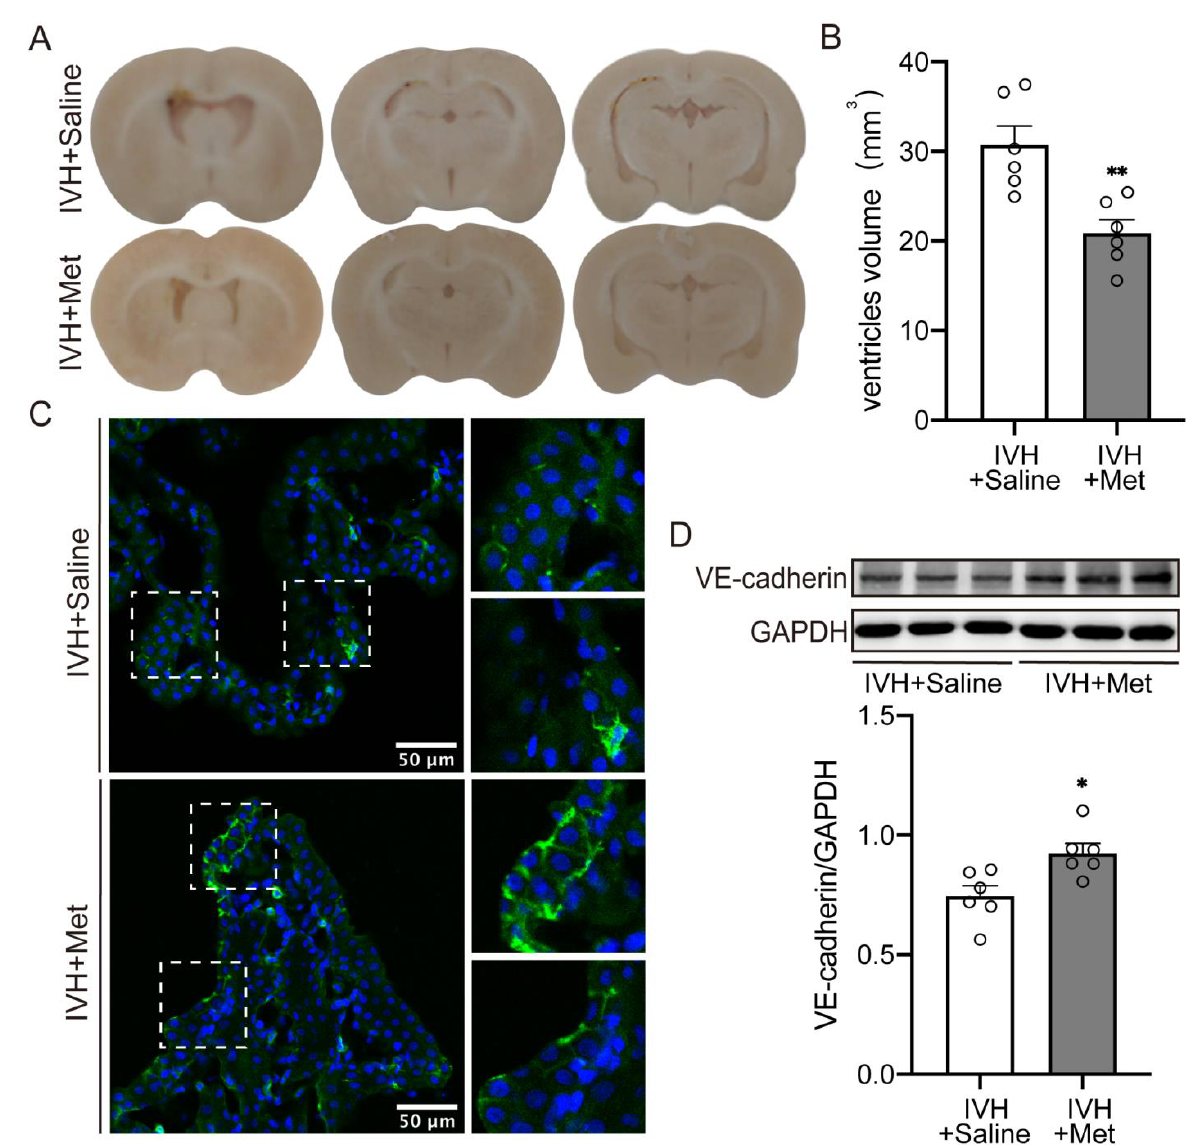
Figure 2. Metformin attenuated the hydrocepralus and increased VE–cadherin expression in choroid plexus after IVH ( A ) Injection of 200 μL of blood into the right lateral ventricle, rats were then treated with saline or metformin for 7 days, examples of frozen coronal brain sections. ( B ) Quantification of lateral ventricle volume from section images, n = 6. ( C ) Immunofluorescence staining of coronal sections showed the expression of VE – cadherin in choroid plexus, n = 4, Scale bar = 50 μ m. ( D ) VE – cadherin expression level was assessed by western blot, n = 6. Data were analyzed by t-test for comparisons between two groups. Values are means ± SEM, * p < 0.05, ** p < 0.01.